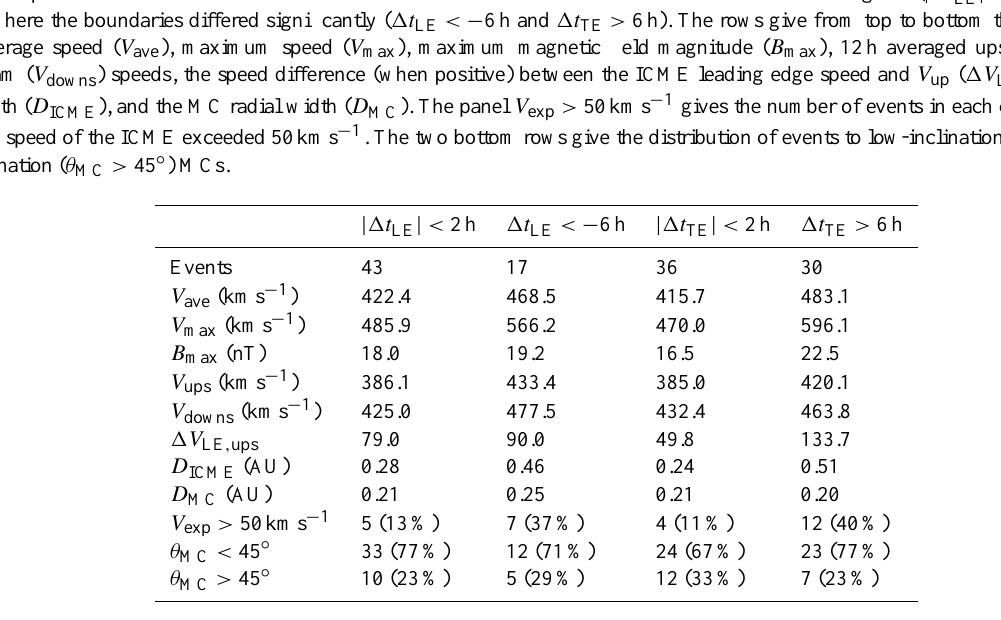
Table 2. Comparison of the ICME characteristics between the events where the ICME and MC boundaries agreed ( | 1t LE | < 2h and | 1t TE | < 2h) and where the boundaries differed significantly ( 1t LE < − 6h and 1t TE > 6h). The rows give from top to bottom the averages of